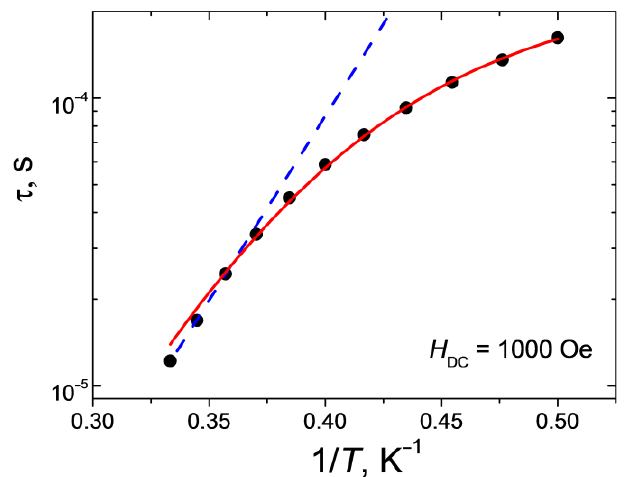
Figure 9. Dependence of the relaxation time τ on the reciprocal temperature for 1 at H = 1000 Oe. Lines show approximations of the curves by Orbach (blue dashed line) and sum of Raman and direct (red solid line) relaxation mechanisms.